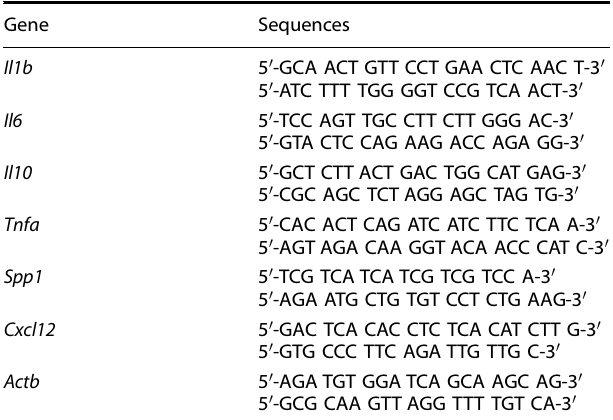
Table 1. Primer sequences for qPCR Gene